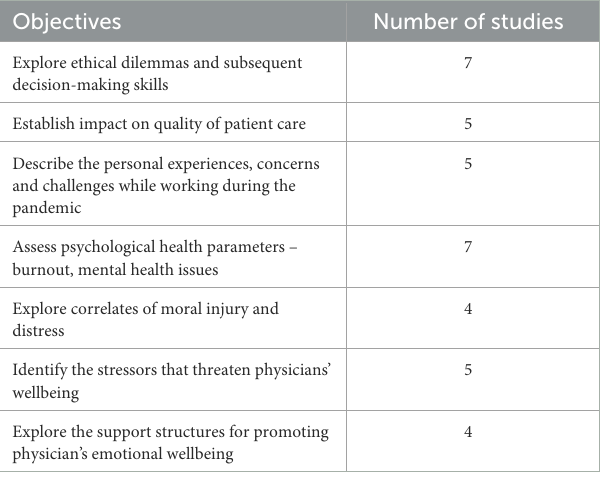
TABLE 2 Leading research objectives of the selected studies about physicians’ psychological health and personal and professional wellbeing in COVID-19 ( n = 28) ∗